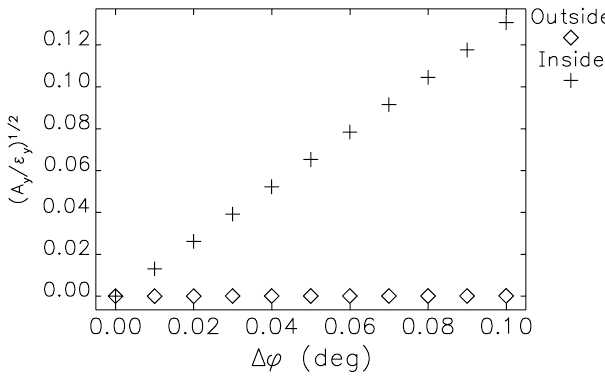
FIG. 21. Beam centroid normalized to beam size as a function of common phase error of the crab cavities, for h (cid:3) 8 and V (cid:3) 4 MV .